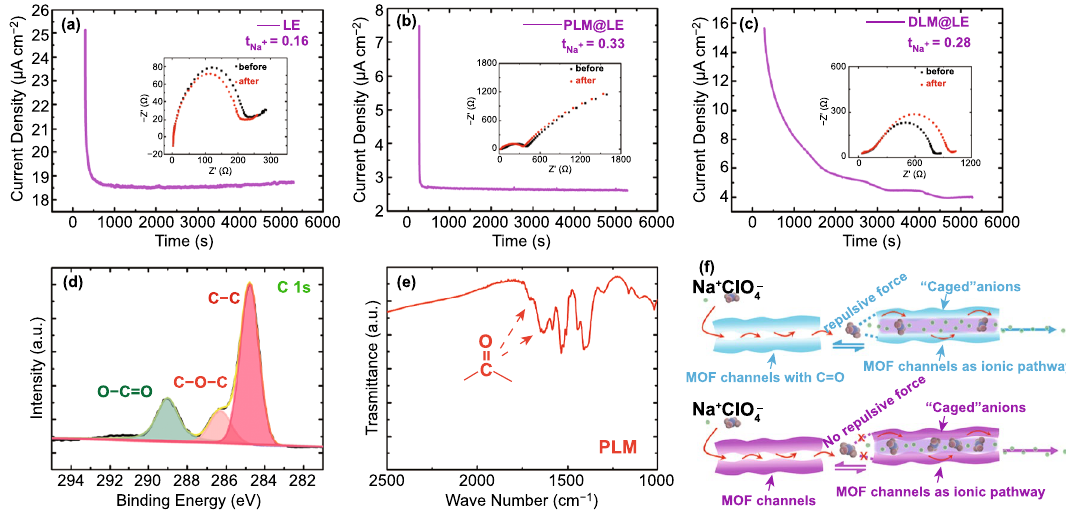
Fig. 4 Current–time profile for a Na//LE//Na, b Na//PLM@LE//Na and c Na//DLM@LE//Na cell. Inset: EIS before and after polarization. d High-resolution XPS spectrum of C 1 s for PLM. e FTIR spectrum of PLM. f Schematic of the selective Na + ionic transport imposed by the MOF